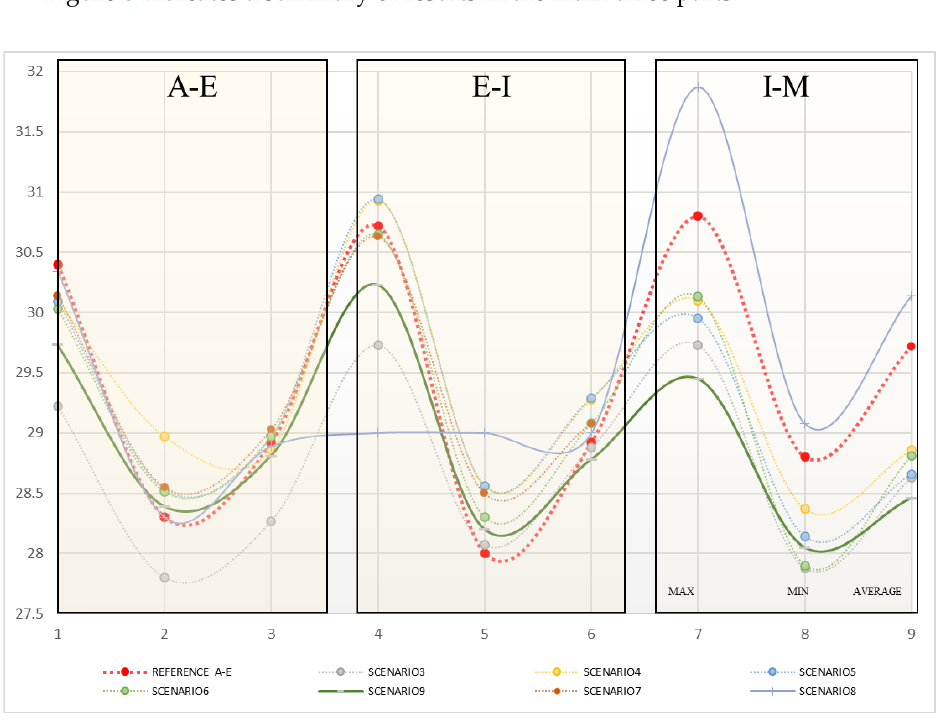
Figure 6. Comparison of ambient air temperature overall mitigation